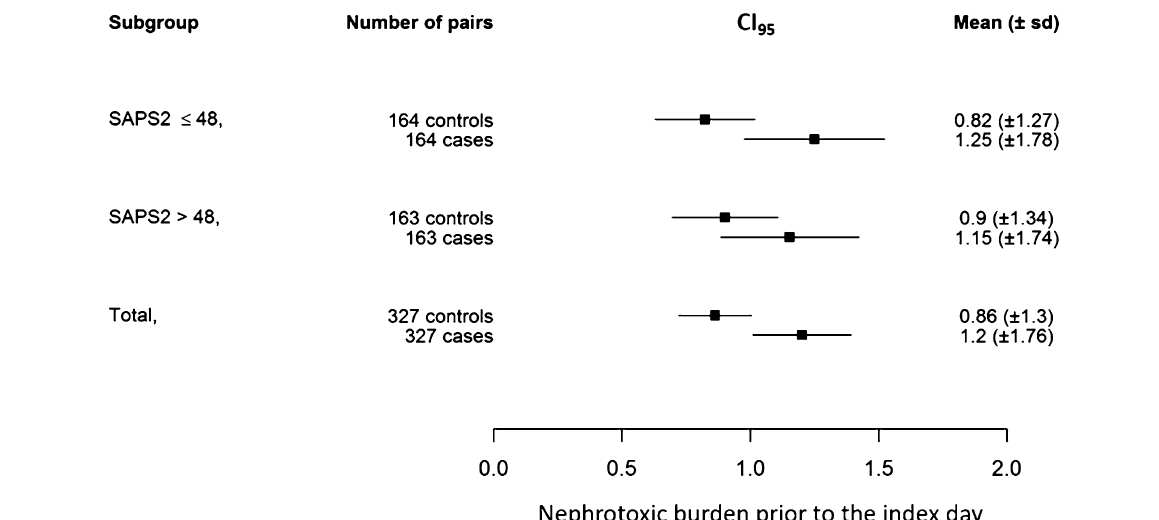
Fig. 3 Severity of disease sensitivity analysis. Squares represent mean values of the nephrotoxic burden prior to the index day with error bars indicating 95% confidence interval (IC 95 ). Whereas nephrotoxic burden prior to the index day was higher among cases than controls in the overall population [bottom line: associated odds ratio (OR) 1.20, IC 95 1.04–1.38] and among patients with a simplified acute physiology score 2 (SAPS2) below the median value of the population (SAPS2 48) indicating lower severity of disease (upper line, associated OR 1.26 IC 95 1.03–1.56), no such = association was observed among the most severe patients (SAPS2 > 48, middle line, associated OR 1.13 IC 95